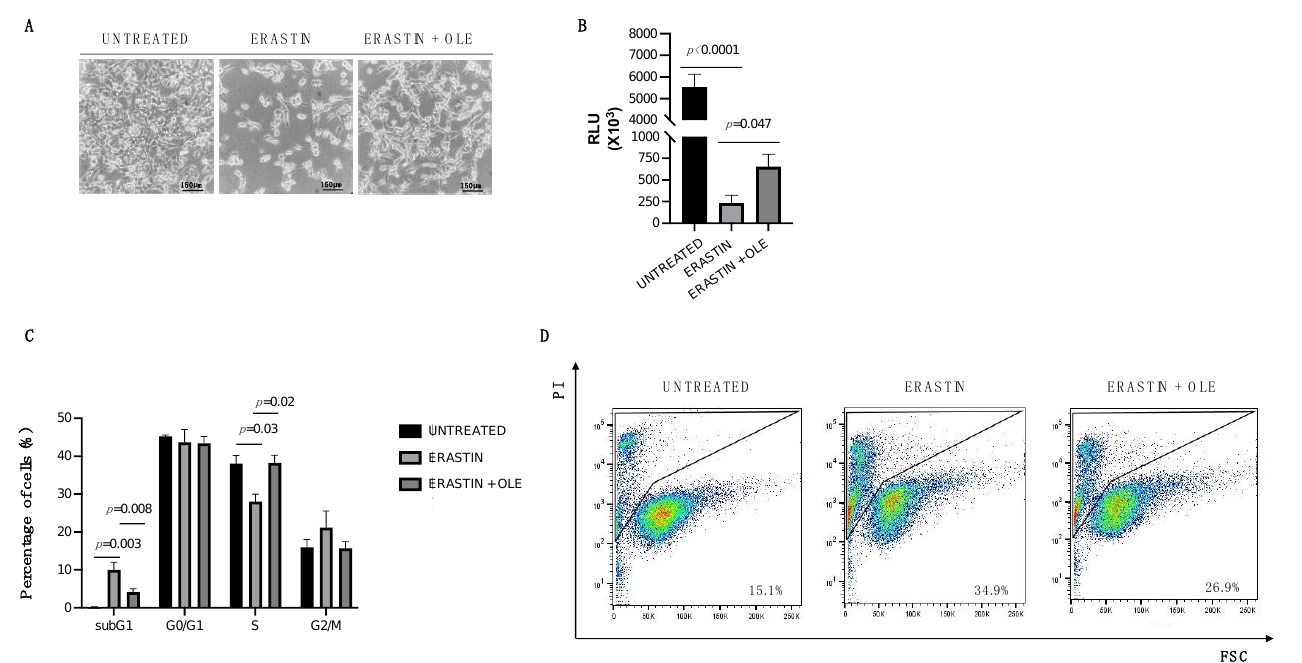
Figure 3. OLE administration protects HEY cells from cytotoxic effects induced by erastin. ( A ) Representative optical microscopy images of HEY cells untreated, treated with 2.5 µ M erastin alone, or in combination with OLE (100 µ M) for 24 h. Scale bars: 150 µ m. Magnification: 100X. ( B ). A bar diagram of cell viability assessed by Cell Titer-Glo Luminescent cell viability assay of HEY cells untreated, treated with 2.5 µ M erastin alone, or in combination with OLE (100 µ M) for 24 h. ( C ) A bar diagram of the number of cells in each phase of the cell cycle based on PI staining. ( D ) Flow cytometric analysis showing PI staining of HEY cells untreated, treated with 2.5 µ M erastin alone, or in combination with OLE (100 µ M) for 24 h. Values (mean ± SEM; n = 3) are shown. Statistically significant difference was determined by Student’s t -test.